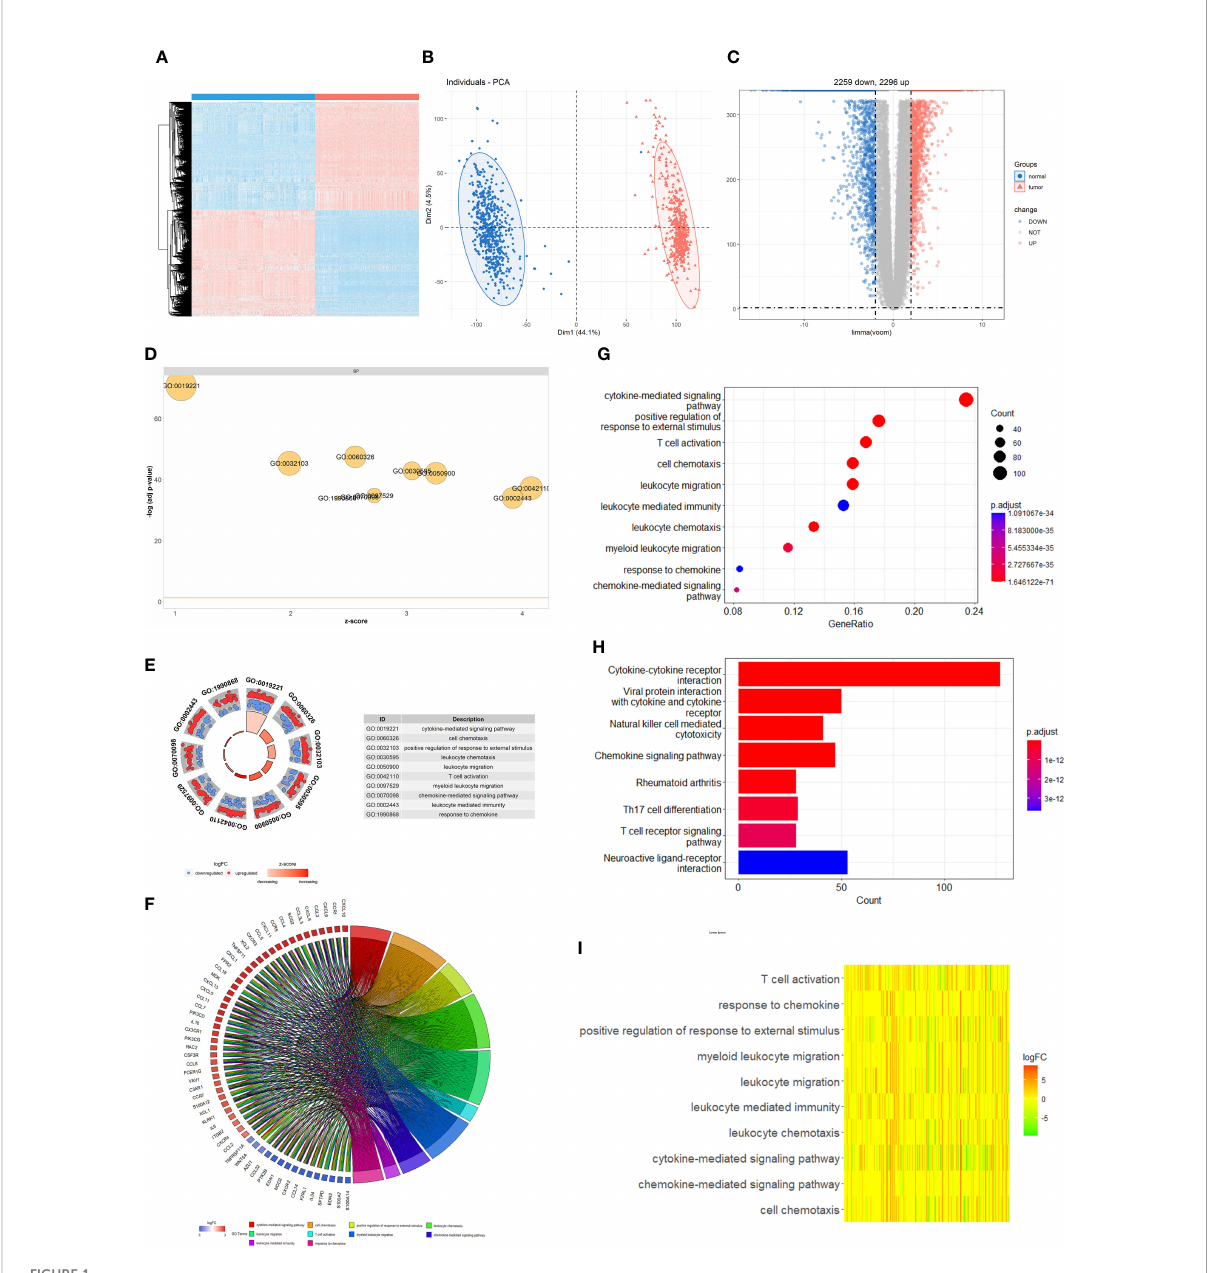
FIGURE 1 Difference of genomic landscape between normal and cutaneous melanoma. (A) Hierarchical clustering of differentially expressed genes between normal and cutaneous melanoma samples. Red represents up-regulated and blue represents down-regulated. (B) PCA visualization of differentially expressed genes. (C) Volcano plot of differentially expressed genes. (D) Biological processes enrichment of gene ontology functional enrichment. (E) Molecular function enrichment of gene ontology functional enrichment. (F) Chord plot of gene ontology functional enrichment. The left half-circle indicates that the genes are sorted by |logFC| and the right half-circle indicates that the gene ontology enrichment analysis term is sorted by strong and weak variation. Red represents up-regulation and blue represents down-regulation, and color shades represent fold change. (G) Cellular component enrichment of gene ontology functional enrichment. (H) KEGG pathway enrichment analyses for differentially expressed genes. All enriched pathways were signi fi cant and the color depth represented enriched adjusted P value. (I) Heatmap of differentially expressed genes between normal and cutaneous melanoma samples. Different colors represent different interaction strength